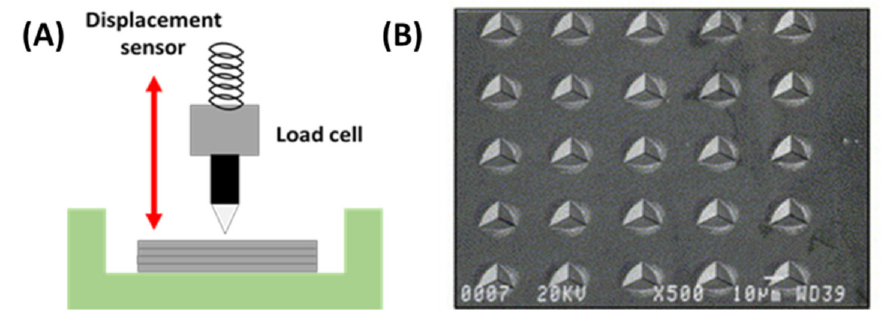
Figure 25. ( A ) Schematic illustration of an instrumented indentation system. ( B ) Indentations are a distance of 10 µ m apart on a square of approximately 40 × 40 µ m.